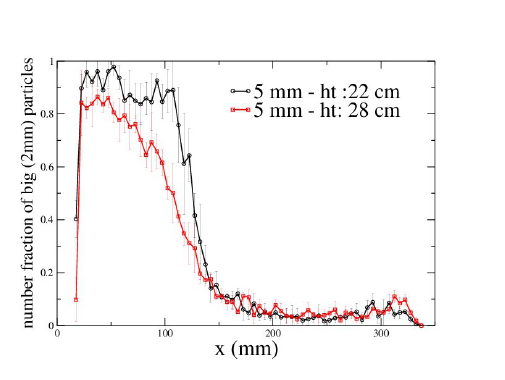
Figure 9. Comparison of number fraction of big particles (2mm) vs component x (mm) for surface layer. For height variation : 22 cm & 28 cm, volume of pouring 150